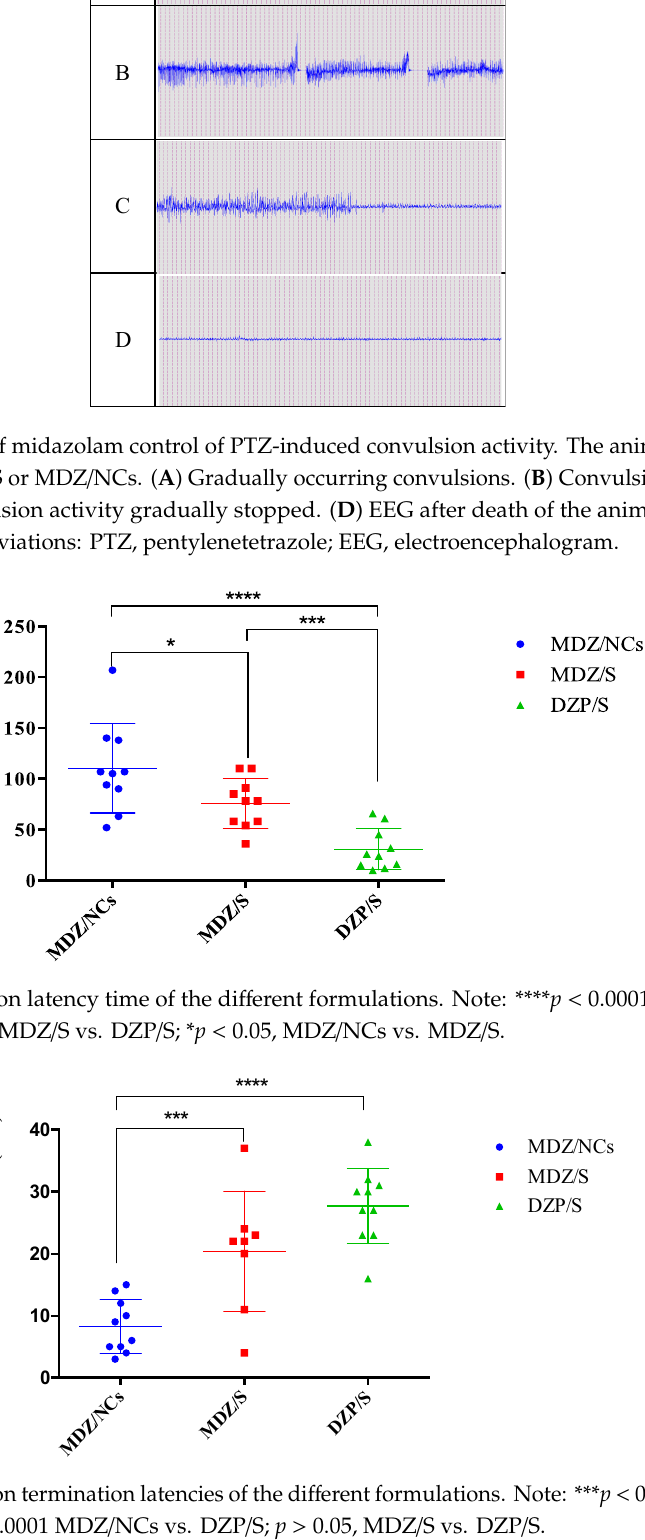
Table 7. Summary of the anticonvulsant effects of the MDZ treatment in the MST model.